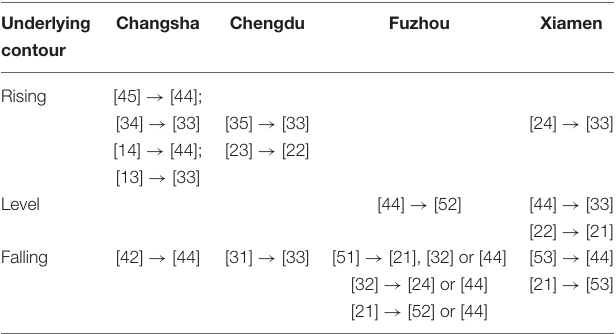
TABLE 7 | The tonal alternations in the metrically weak position across the four dialects.